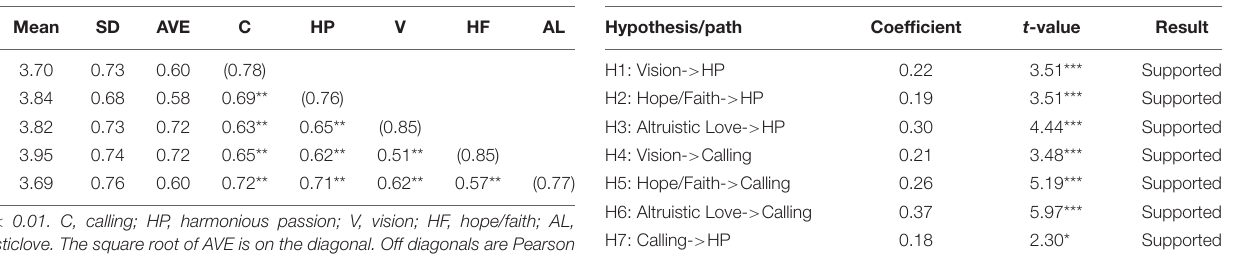
TABLE 4 | Results of descriptive statistics and correlations.